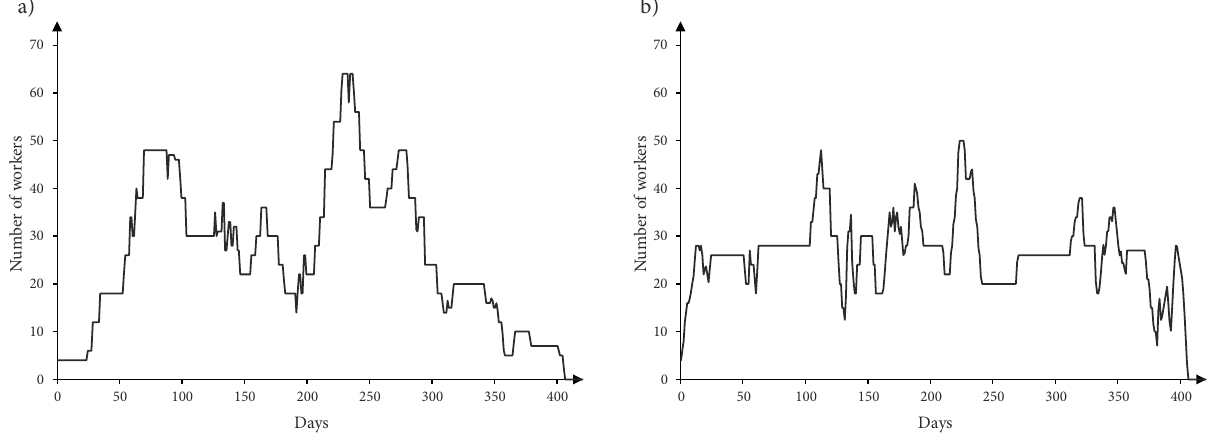
Figure 14. The second comparison: a – resource usage cure of Dolabi et al. (2014); b – resource usage cure of the proposed